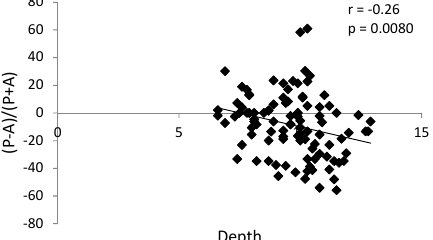
Figure 11. Graph presenting statistically significant negative correlation between glenoid fossa depth and sagittal position of the condyle in the glenoid fossa in the group with TMJ reciprocal clicking.